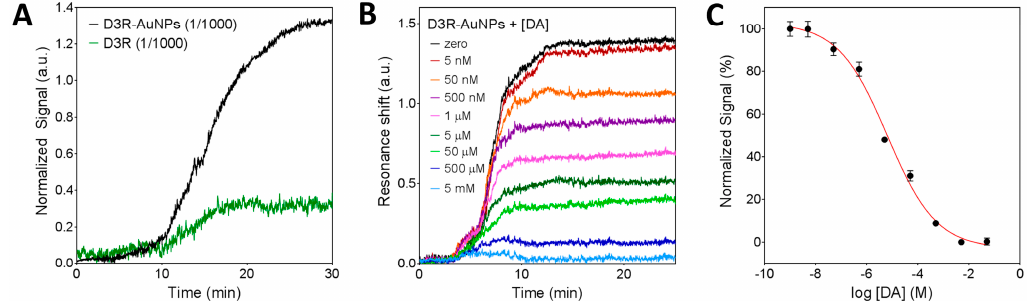
Figure 4. Characterization of the nanoplasmonic biosensor for indirect DA detection. ( A ) Sensorgrams obtained for the detection of pure D3R and gold nanoparticles conjugated D3R (D3R-AuNPs) on the DA-BSA functionalized surface. ( B ) Sensorgrams obtained for indirect detection of dopamine at different concentrations (5 nM–5 mM). ( C ) Standard dose-response inhibition curve for indirect detection of DA. Plots represent mean and standard deviation of each DA concentration (1 nM–5 mM) measured in triplicate.